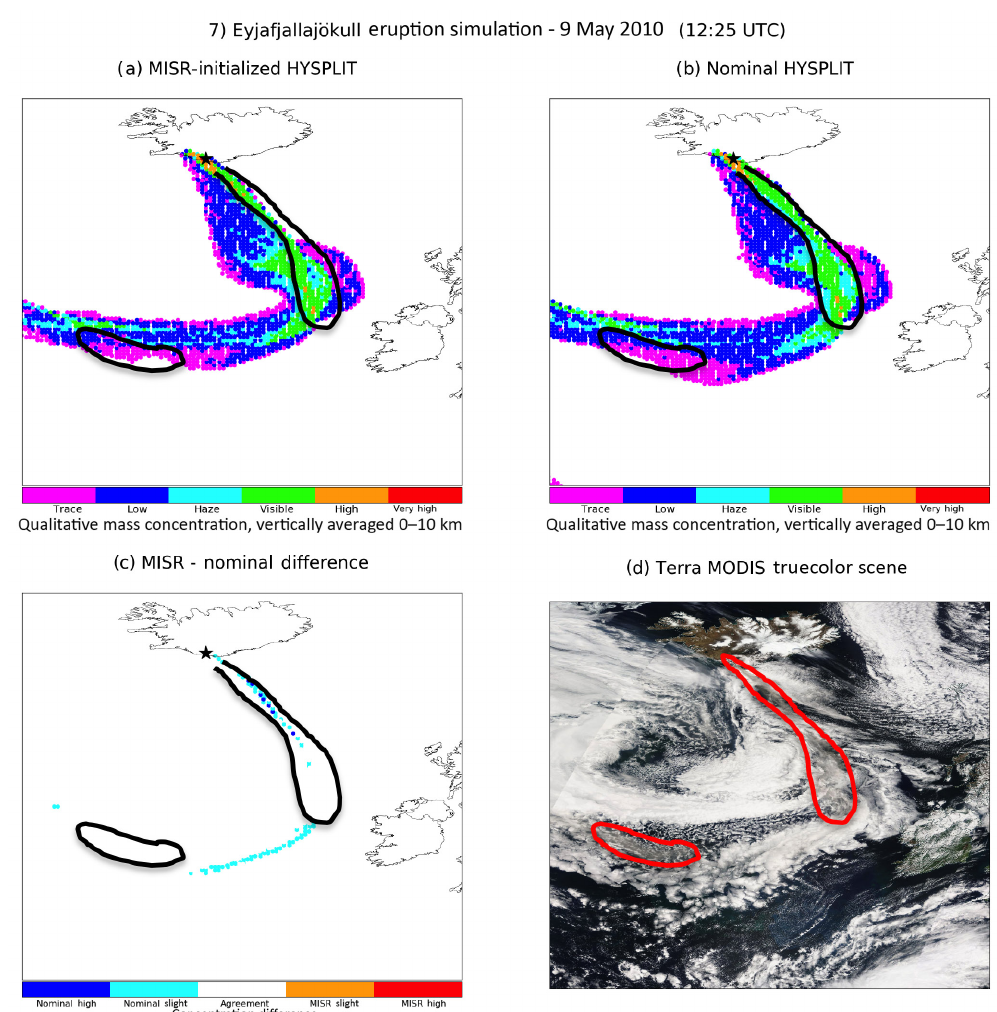
Figure 7. Same as Fig. 2, but for the Eyjafjallajökull volcanic eruption plume, on 9 May 2010. (a–b) Day 3 samplings of HYSPLIT 96h simulations that began on 7 May 2010, and (c) Day 3 difference plot. (d) MODIS true-color image acquired on 9 May